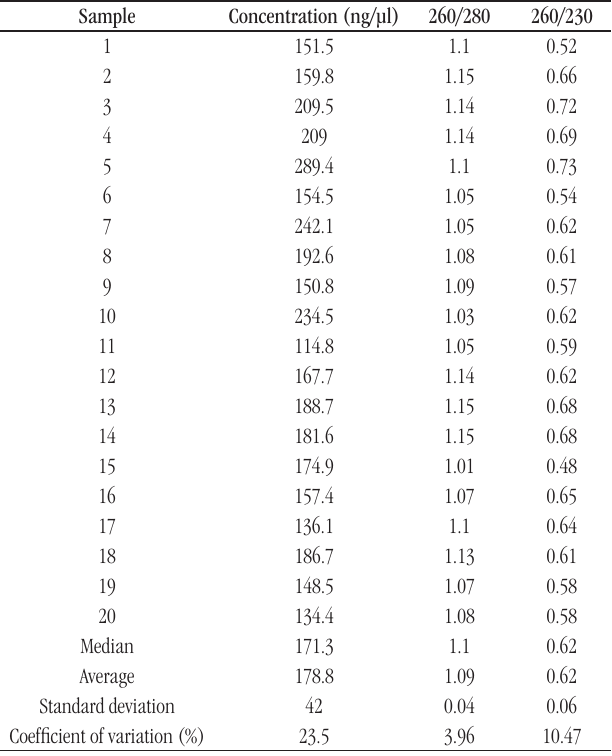
taBLE 3 − Concentration and ratios 260/280 and 260/230 of the samples